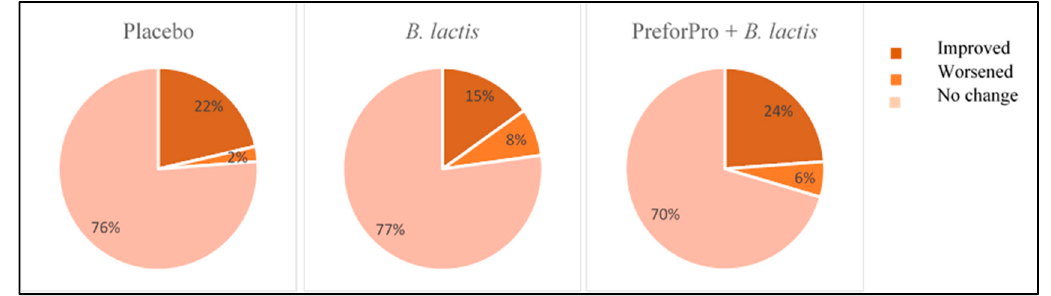
Figure 3. Priority changes in overall digestive symptoms from baseline to follow-up.